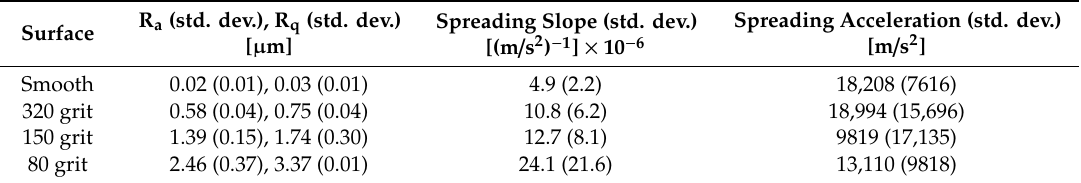
Table 4. Average R a and R q values of hydrophobic coated surfaces compared to spreading slope ((d / d i ) / a m ) and spreading acceleration (a s ) for 10–70 µ L droplets of deionized